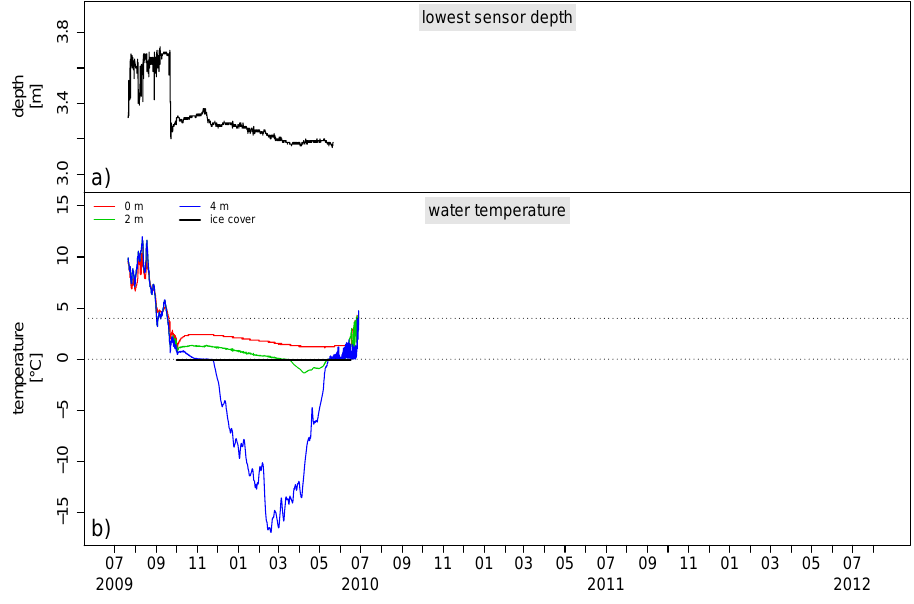
Figure A8. Hourly lake temperatures and lowest sensor depth (indicating water level changes) for Ku_Lake_1, from July 2009 to August 2010. Thick black lines indicate ice-covered